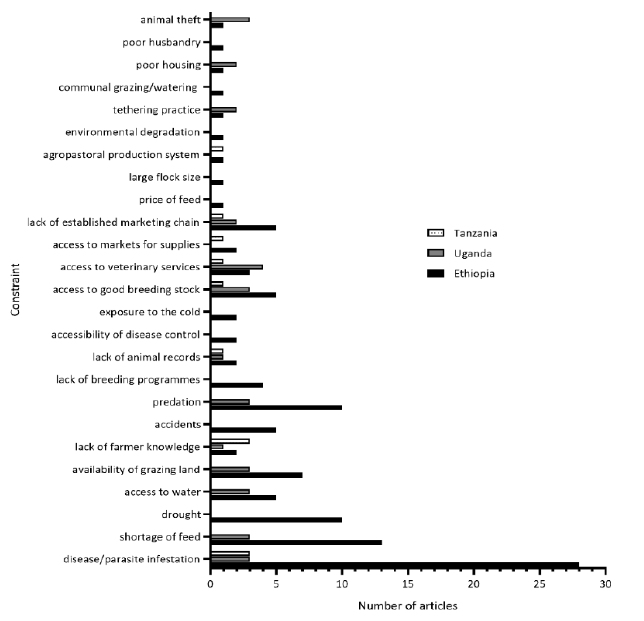
Figure 4. Constraints to small ruminant production identified from eligible articles in Ethiopia, Tanzania, and